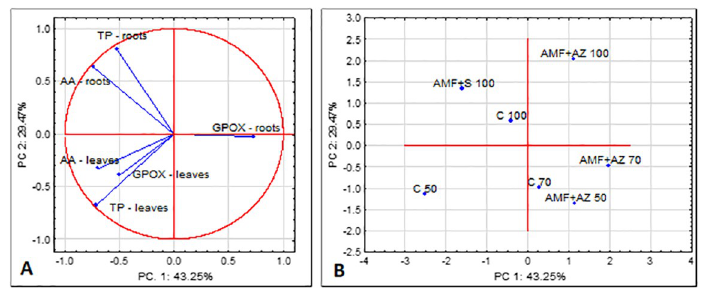
transplants (B). C 50 –peat:sand ratio 50:50 (v:v) without inoculation; C 70 –peat:sand ratio 70:30 (v:v) without inoculation; C 100 –peat:sand ratio 100:0 (v:v) without inoculation; AMF + AZ 50 –peat:sand ratio 50:50 (v:v) inoculated with arbuscular mycorrhizal fungi (AMF) and Azospirillum brasilense (AZ), AMF + AZ 70 –peat:sand ratio 70:30 (v:v) inoculated with AMF and AZ, AMF + AZ 100 –peat:sand ratio 100:0 (v:v) inoculated with AMF and AZ; AMF + S– 100 peat:sand ratio 100:0 (v:v) inoculated with AMF and Saccharothrix tamanrassetensis (S).